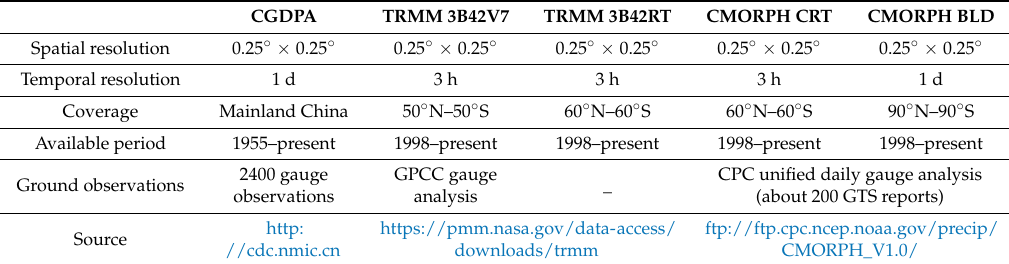
Table 1. Description of the gauged China Gauge-based Daily Precipitation Analysis (CGDPA) and four satellite-based precipitation products in this study.